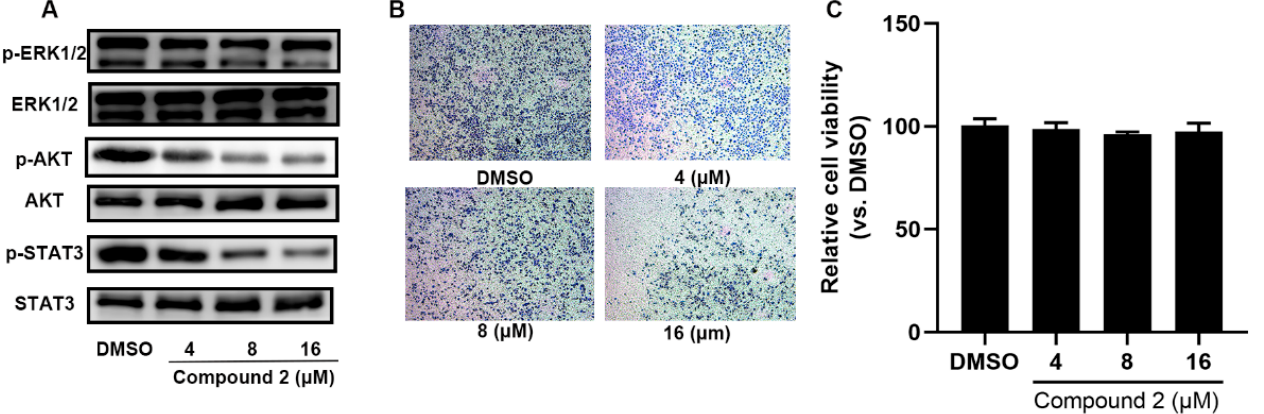
Figure 4. Compound 2 restrains RAF–MEK–ERK signal pathway’s abnormal activation by the down-regulation of SHP2 phosphatase. ( A ) The effects of 72 h of compound 2 treatment on ERK, AKT signaling pathway in A549 cell. ( B ) The effects of 24 h of compound 2 treatment on A549 cell invasion. ( C ) After treatment with DMSO or compound 2 for 24 h, cell viability of A549 cells was detected.